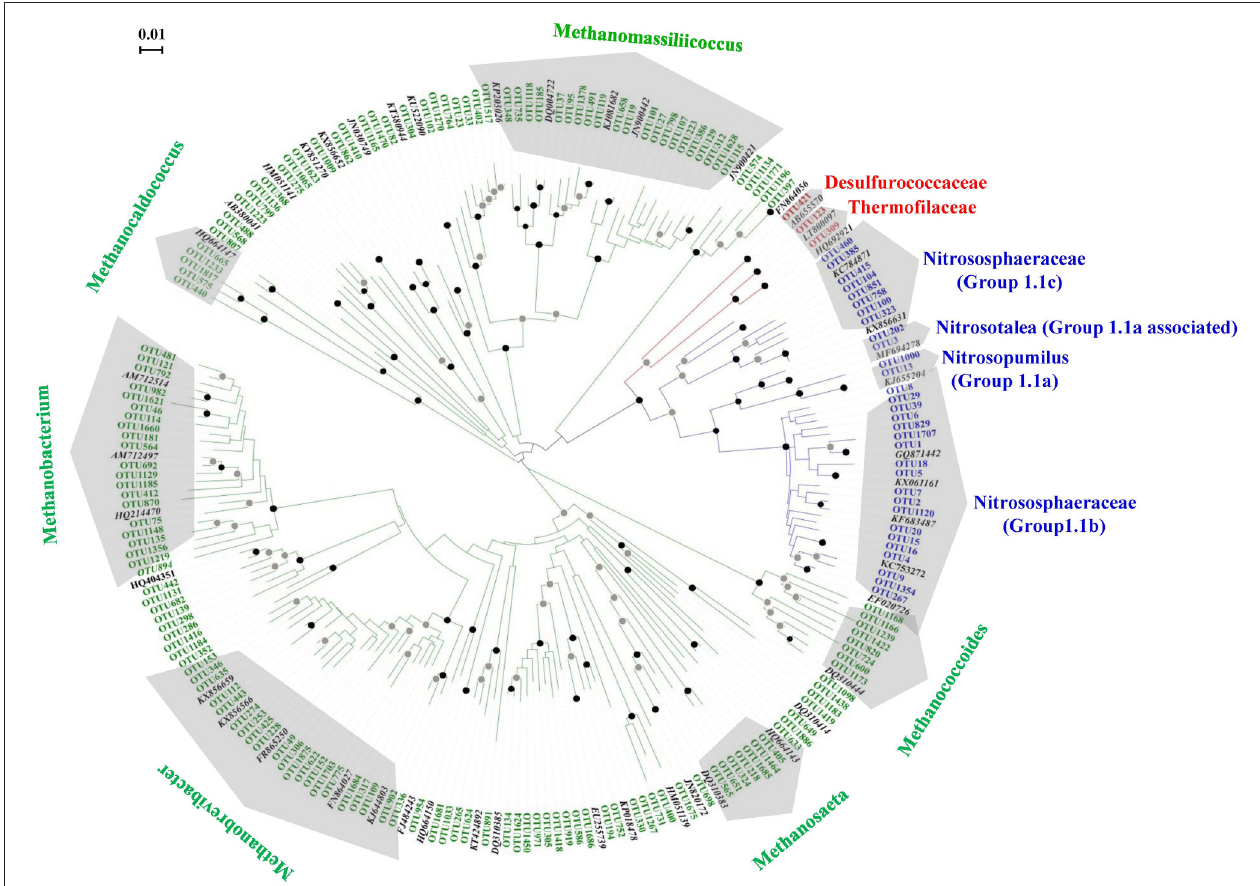
FIGURE 1 | Unrooted phylogenetic tree showing the archaeal OTUs obtained in the black soils with reference clones deposited in the GenBank. The OTU number marked with red, green, and blue letter represented the clones of Crenarchaeota , Euryarchaeota, and Thaumarchaeota , respectively. The reference archaeal clones marked with black letters. The black and gray circles indicate internal nodes with higher than 90 and 50% bootstrap support, respectively.